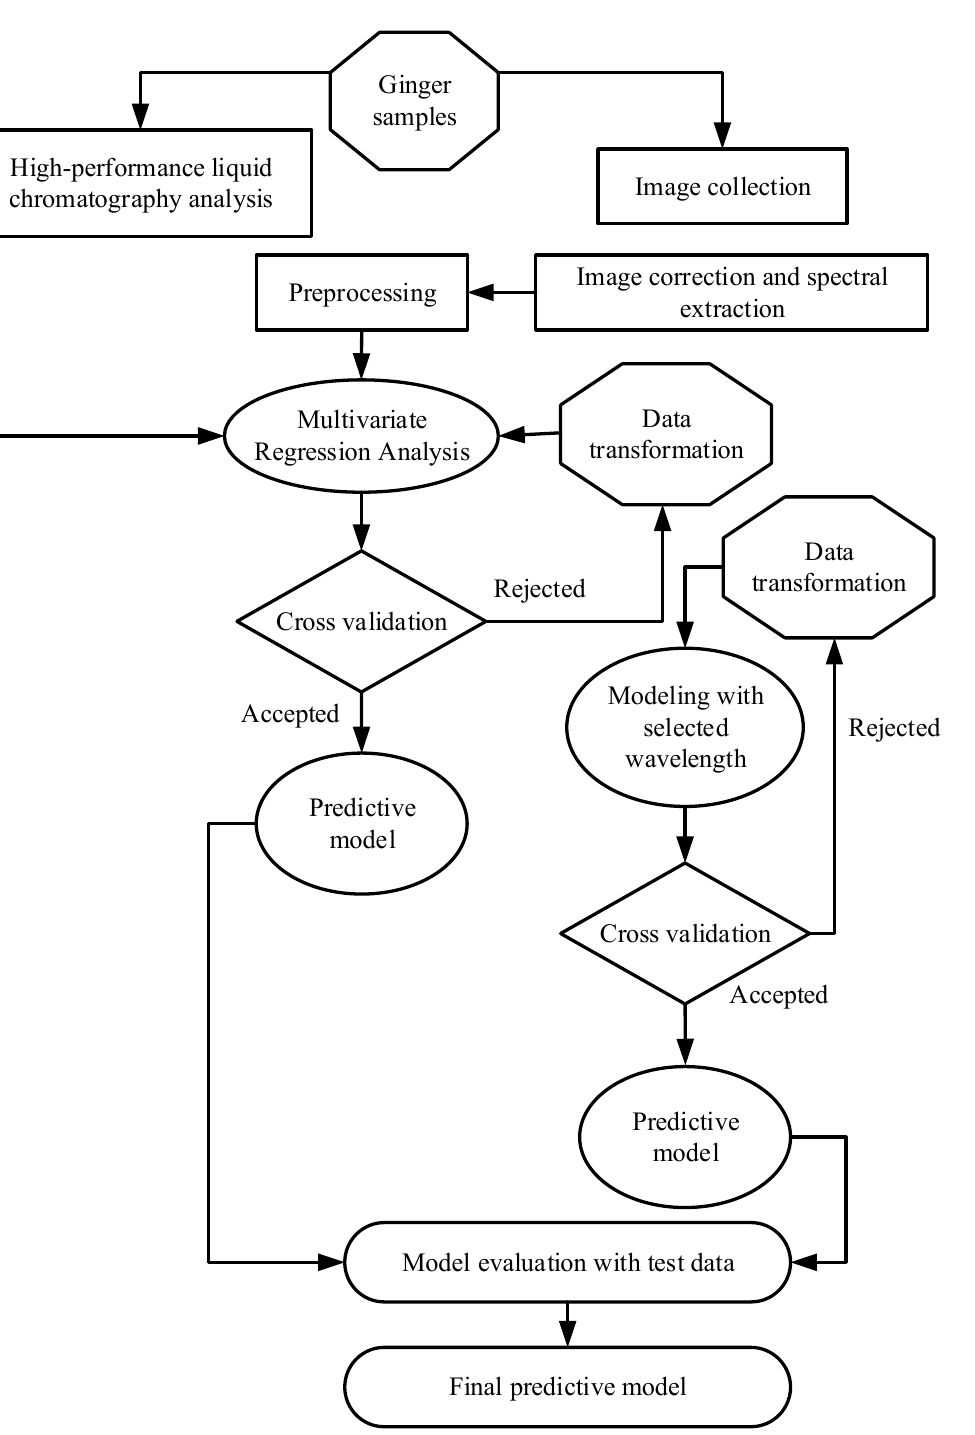
Figure 4. A schematic workflow of data processing and model development.